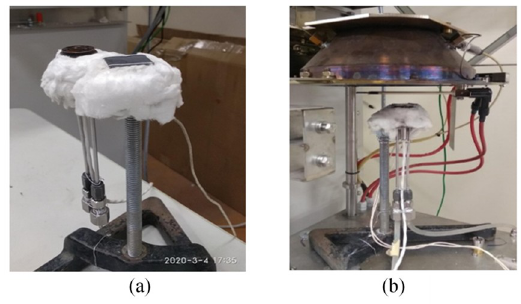
Figure 3. ( a ) Experimental set up of Radiometer and PT; ( b ) Radiometer and PT under the cone heater.